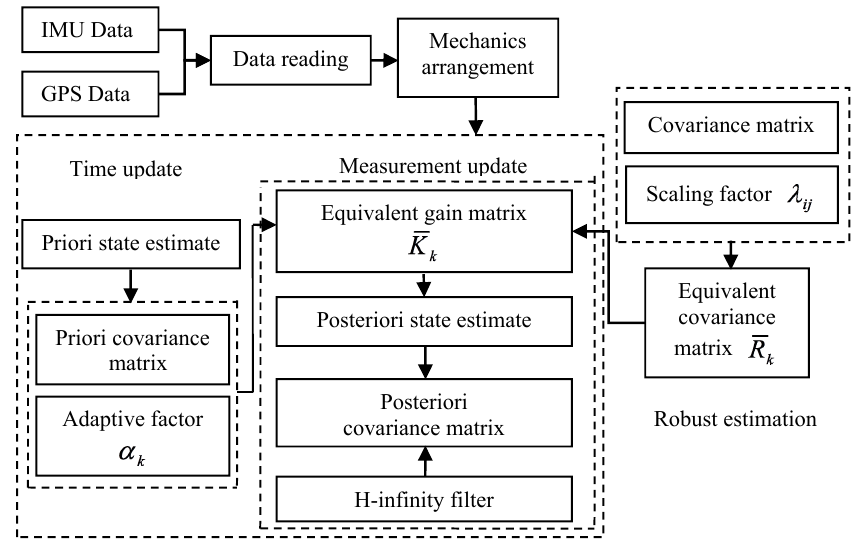
Figure 1. A flow chart of the adaptive H-infinity algorithm.